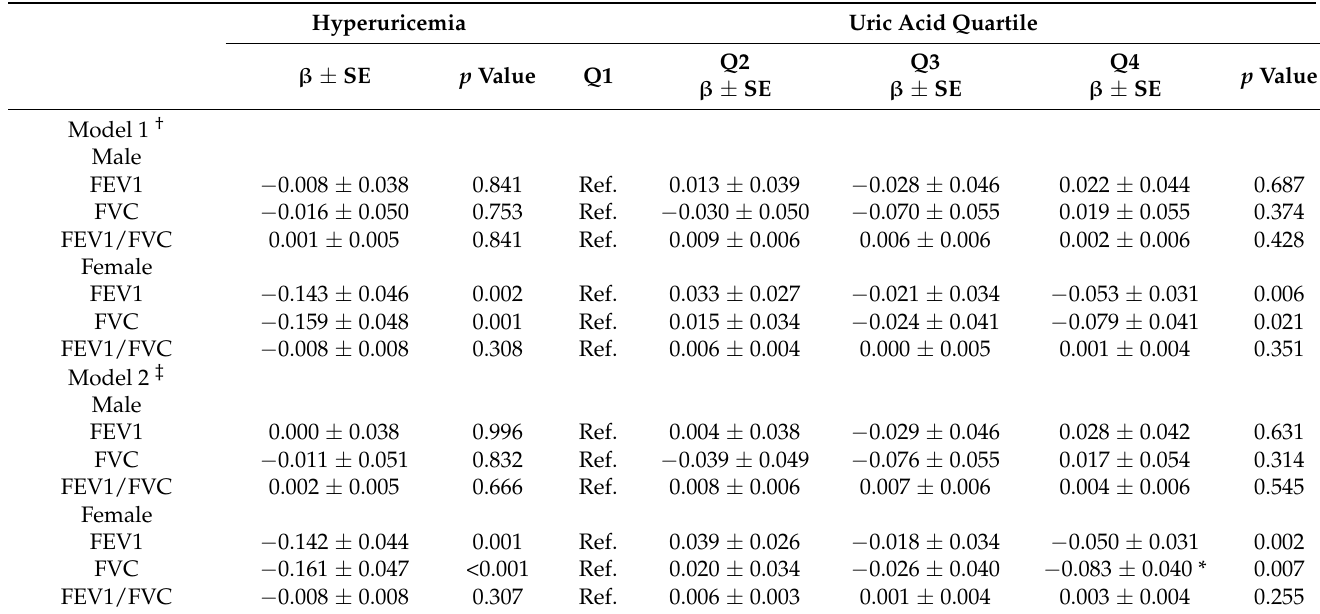
Table 3. Multivariable linear regression analysis for effect of uric acid on pulmonary function. For comparison with lowest uric acid